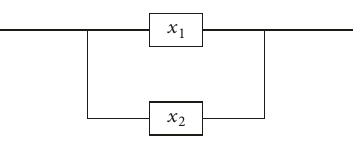
Figure 20: Block diagram of two parallel